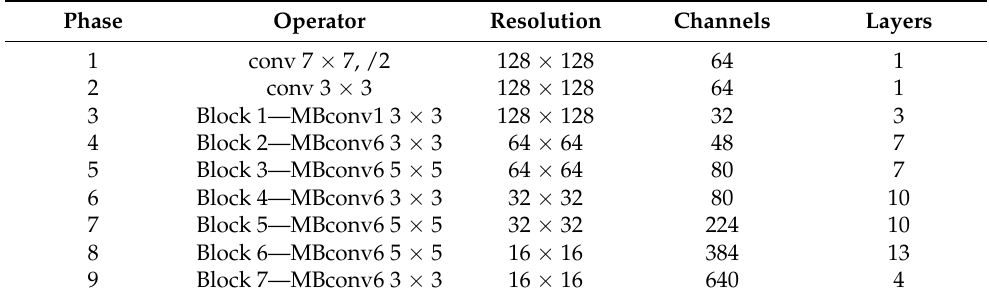
Table 2. The structure of the